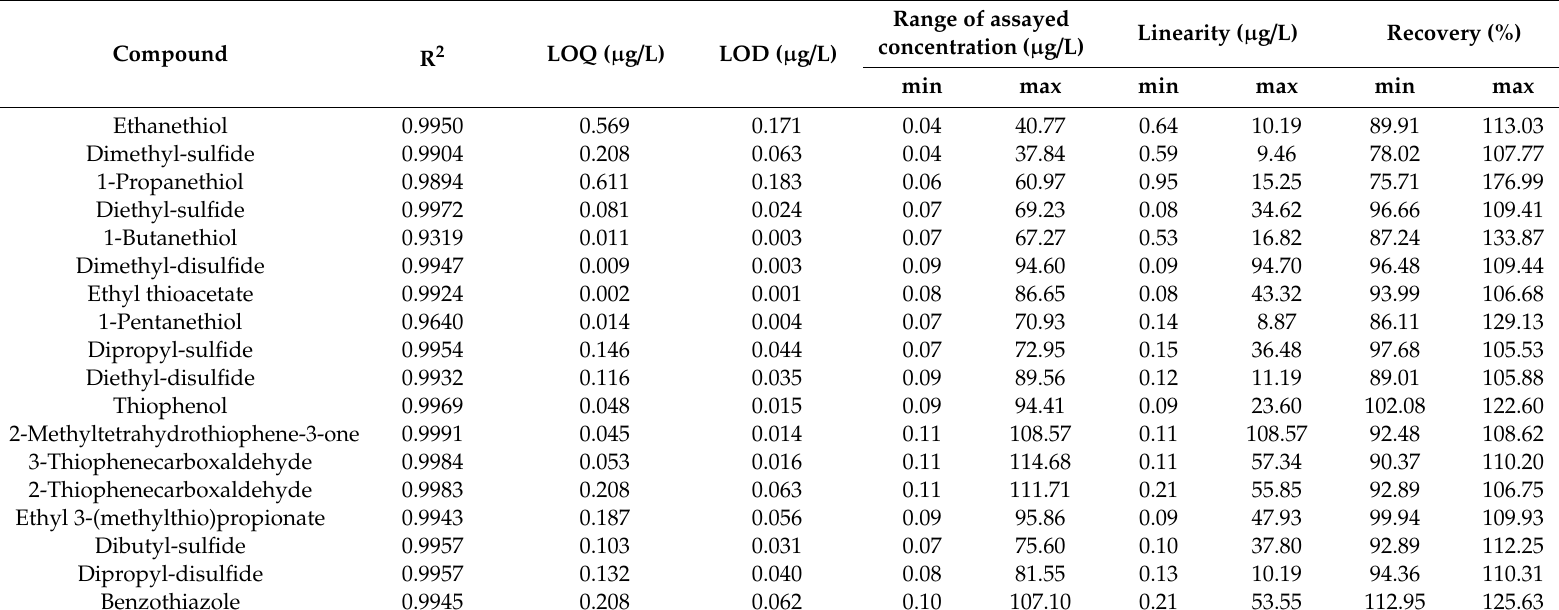
Table 3. Limits of detection and quantification, linearity, and recovery of the